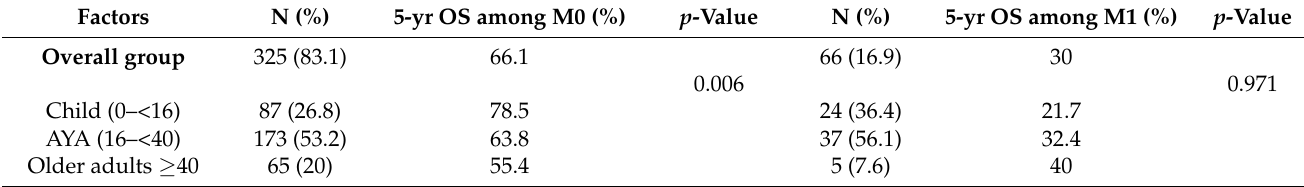
Legend: M0 = patients without metastasis at presentation, M1 = patients with metastasis at presentation.